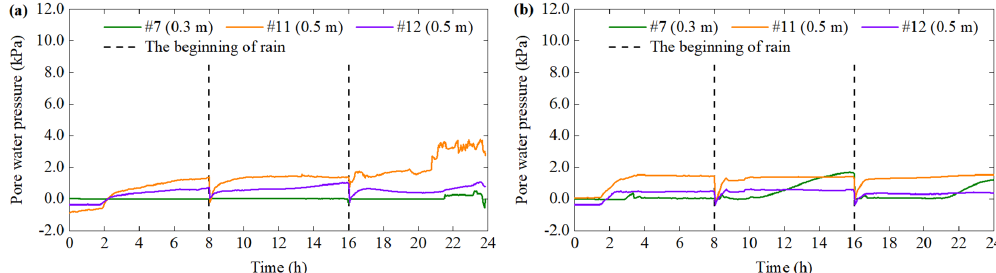
Figure 14. Pore water pressure at position D and E of (a) test 1 and (b) test 2.